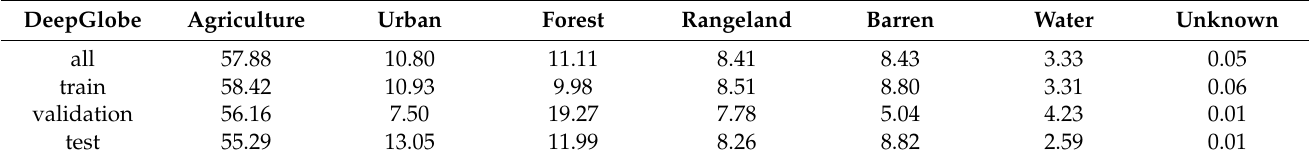
Table 2. The class distribution for the DeepGlobe dataset